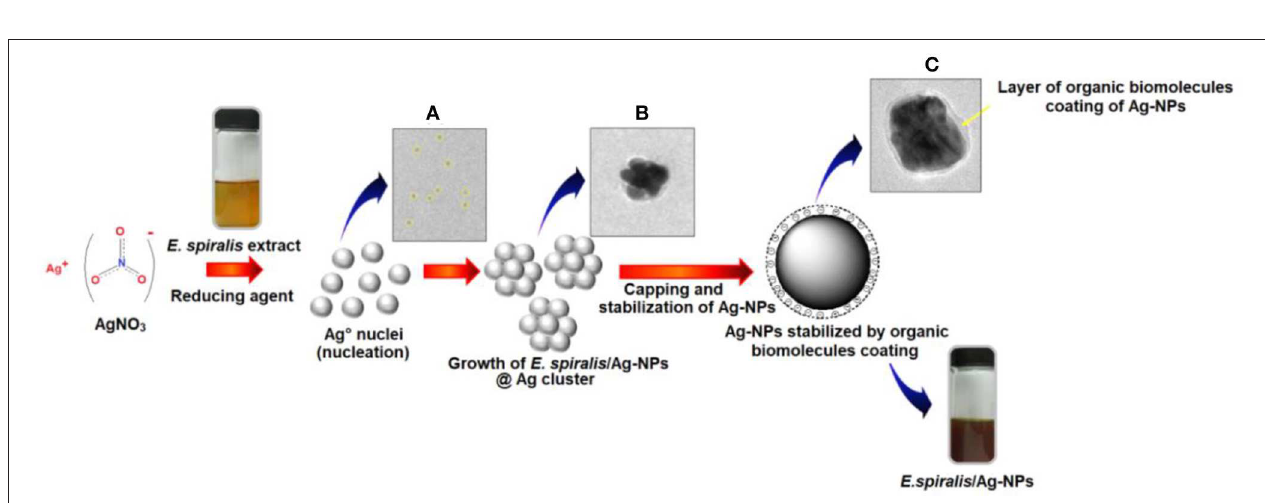
FIGURE 6 | Bottom to top approaches of E. spiralis /Ag-NPs formation. (A) Formation of Ago nuclei. (B) Growth of E. spiralis /Ag-NPs. (C) Stabilization of Ag-NPs by organic biomolecules of E. spiralis extract.